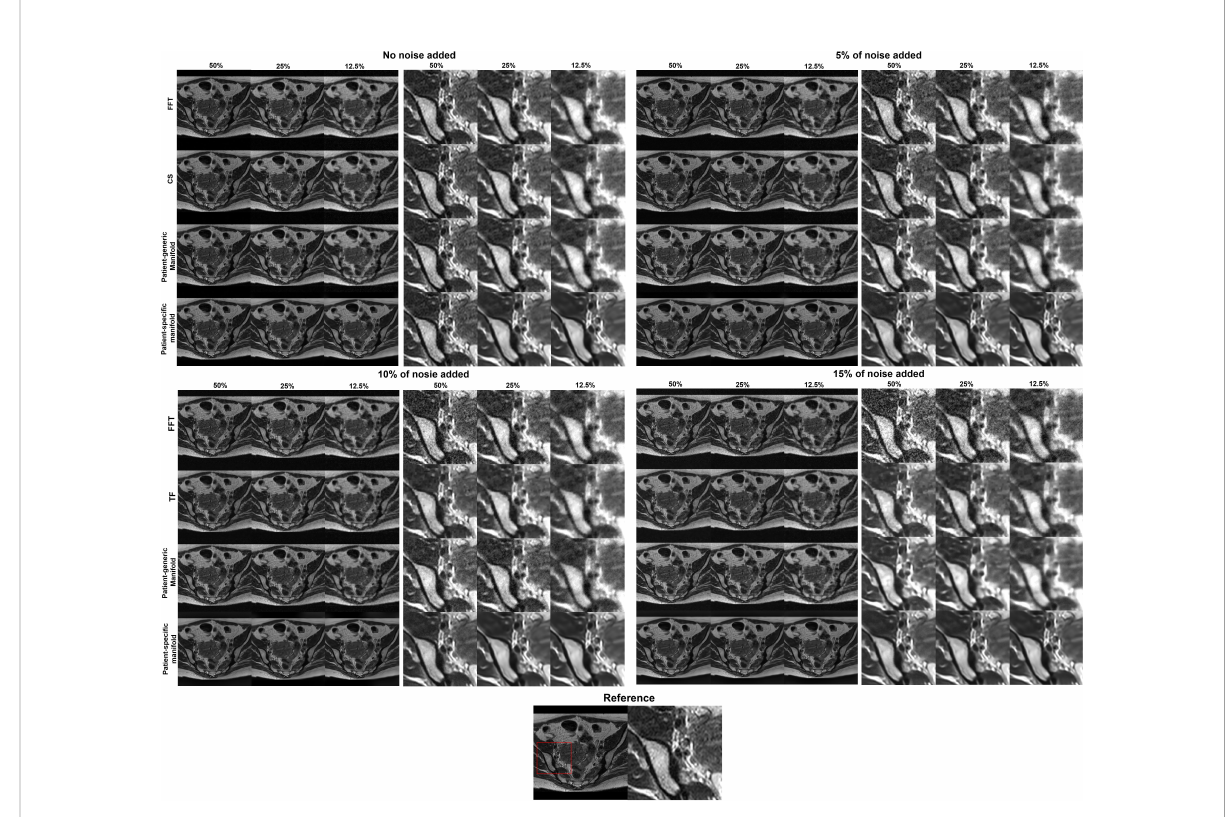
FIGURE 6 Reconstruction results of the simulation case using data with different undersampling ratios and noise levels. The complete images are displayed in a window of [0,1] and the zoomed-in patches are displayed in a narrower window of [0,